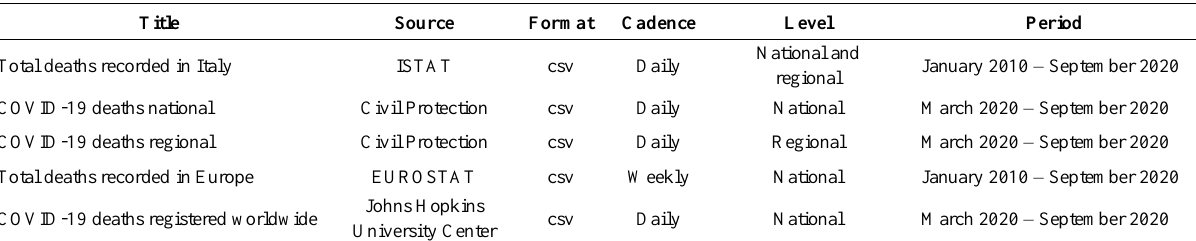
Table 2. Information on collected data.